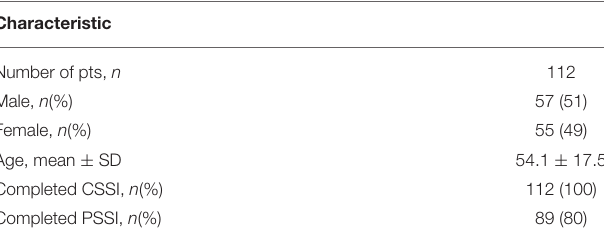
TABLE 1 | Baseline